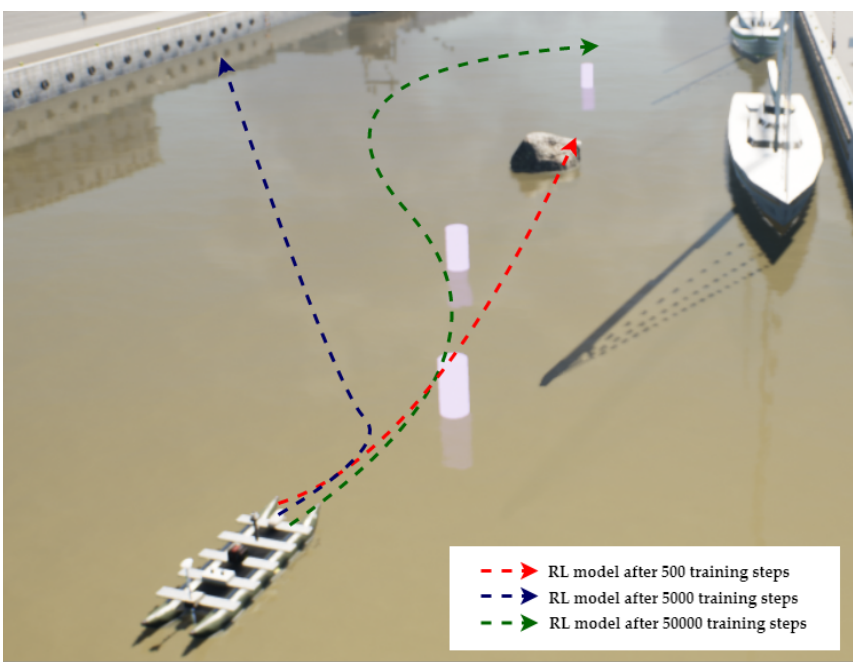
Figure 8. Trajectory Analysis for the SAC